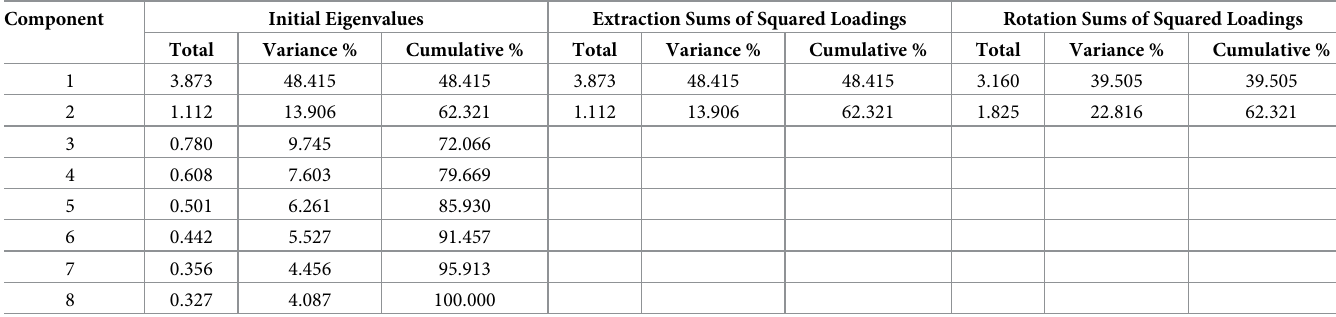
Table 2. Total variance explained in the component